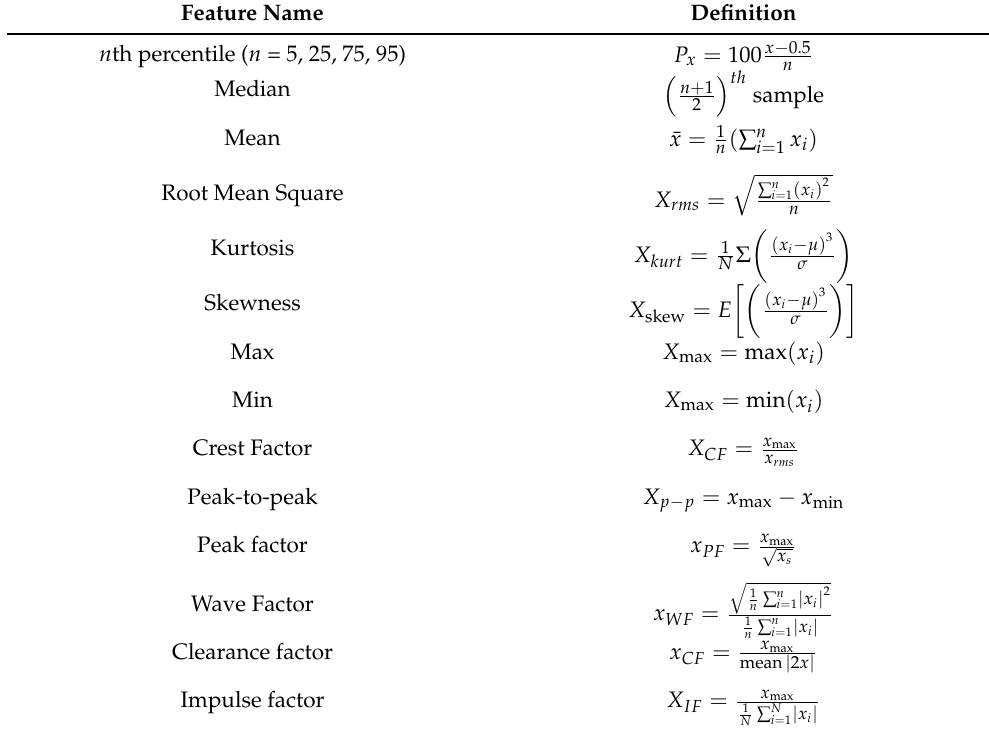
Table 2. Statistically extracted features and their mathematical formulas